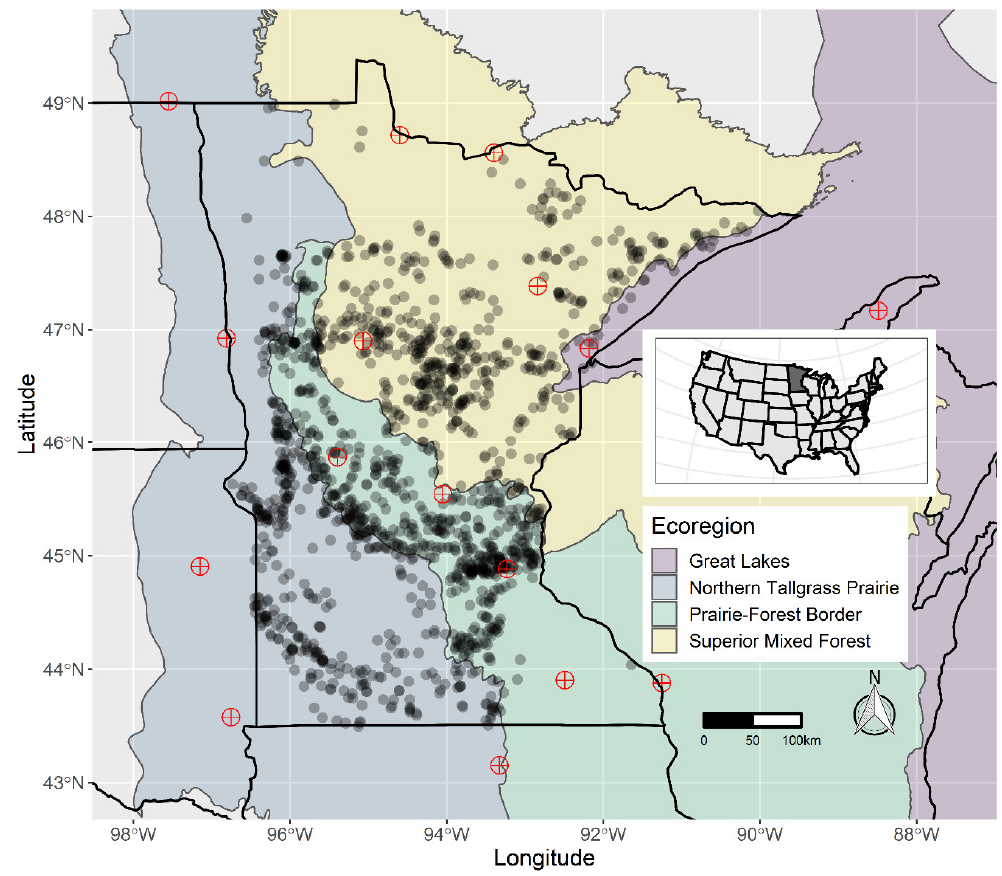
Figure 2. Distribution of lakes with survey data included in this study (translucent black dots) and weather stations used for associated weather data (red circles with crosses) across major ecoregions of Minnesota, USA. Ecoregions represent areas with similar climatic and environmental conditions [63].